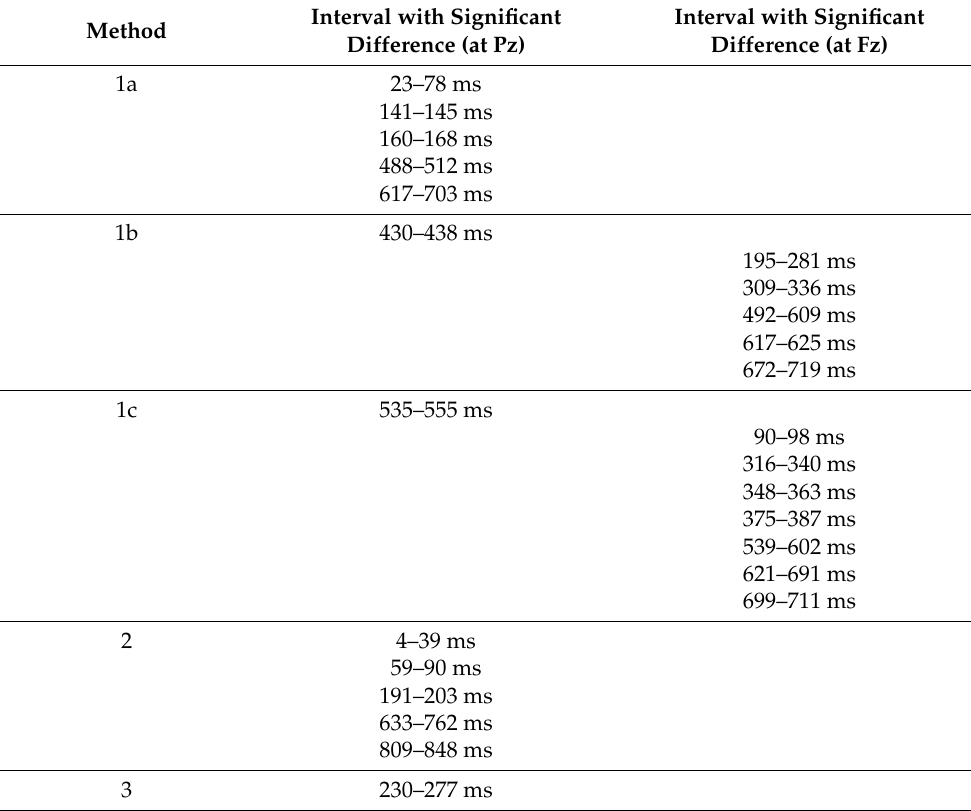
Table 3. Intervals with a significant difference at Pz and Fz for each